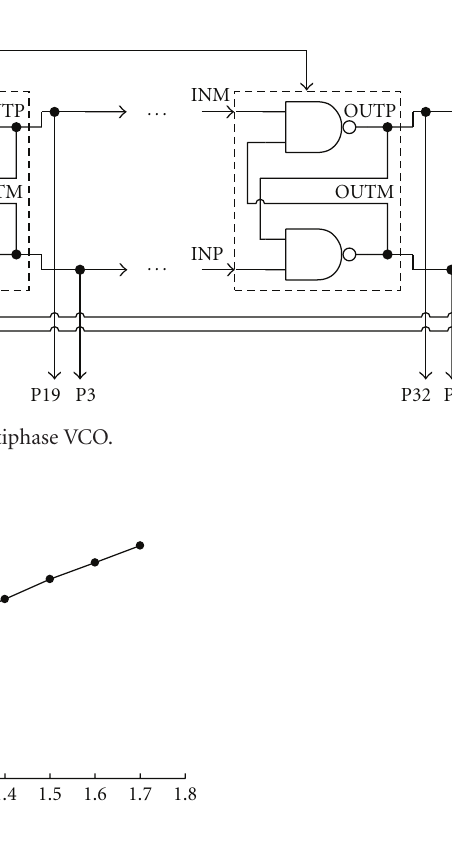
Figure 9: VCO output